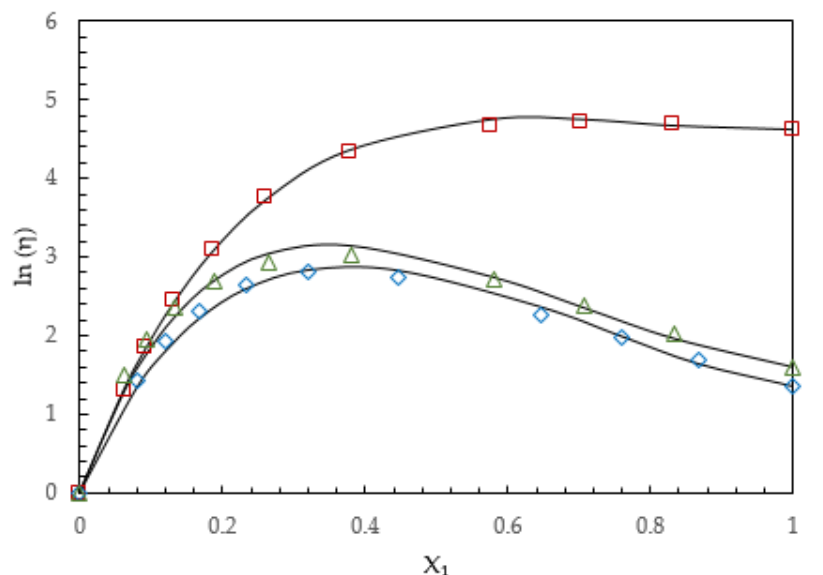
Figure 3. Viscosities of MDEA (1) + H 2 O (2), ‘ □ ’; DMEA (1) + H 2 O (2), ‘ ◊ ’ and DEEA (1) + H 2 O (2), ‘ ∆ ’ mixtures at 293.15 K, Correlation; “ ― ”.